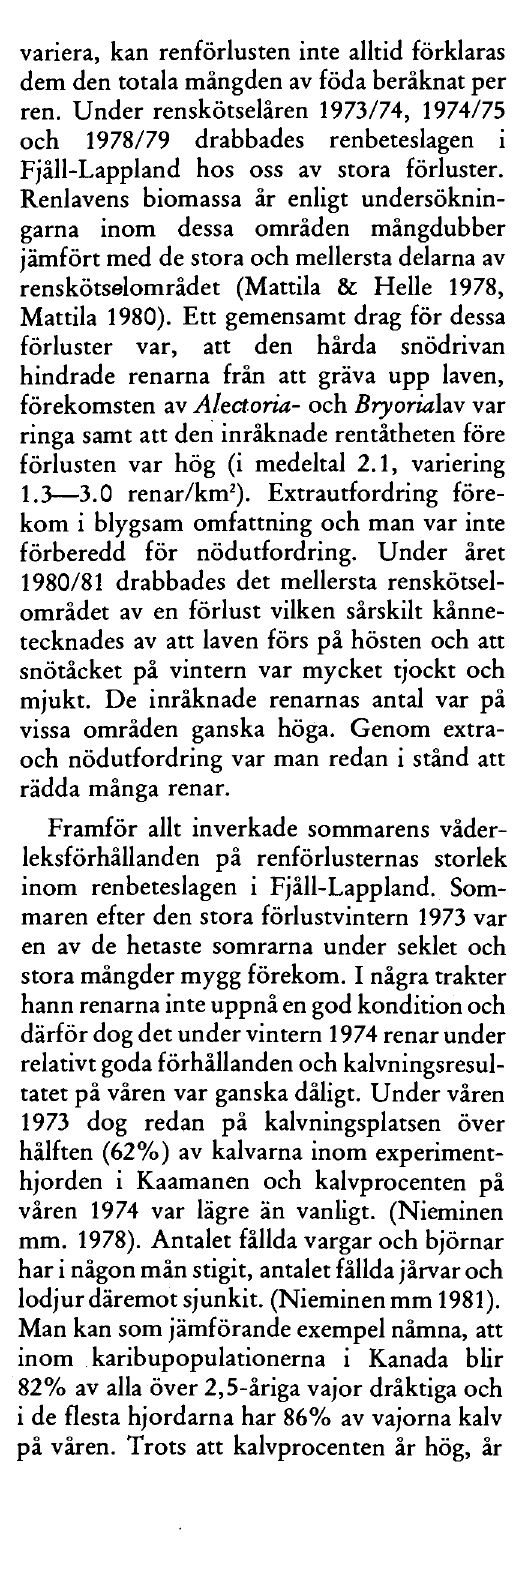
Bild 17. Olika factorer som hindrar våxt av cariboupo- pulation (Bergerud 1980). Fig. 17. Different factors preventing increase of caribou population (Bergerud